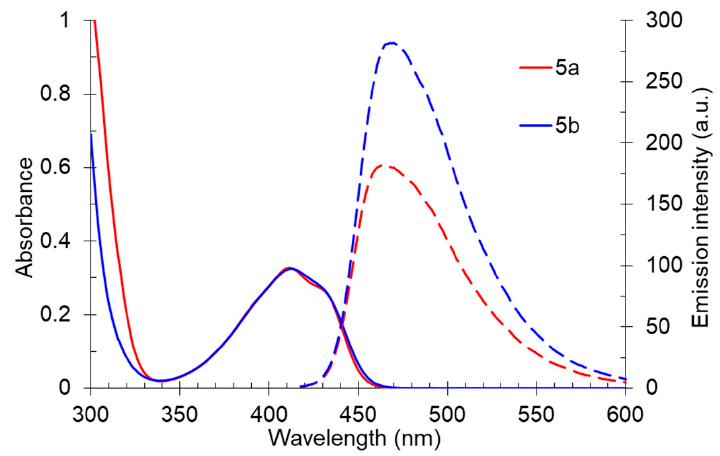
Figure 9. UV-vis absorption (5 × 10 − 5 M, solid line) and emission (5 × 10 − 5 M, dashed line) spectra of compound 5 in toluene.